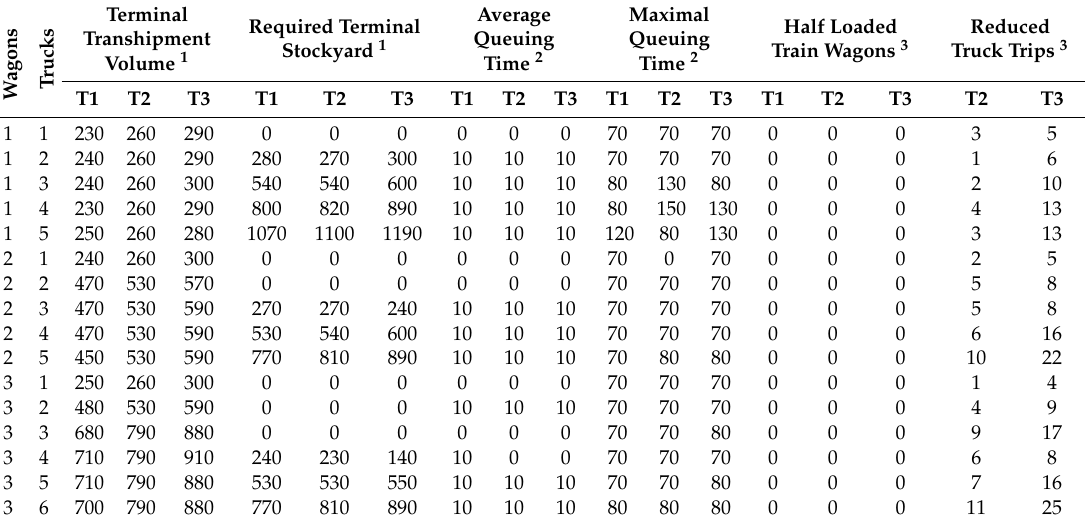
Table A2. Terminal transport template for one train pick-up, medium delivery time, and all tonnages (P1D2 T1 / 2 /